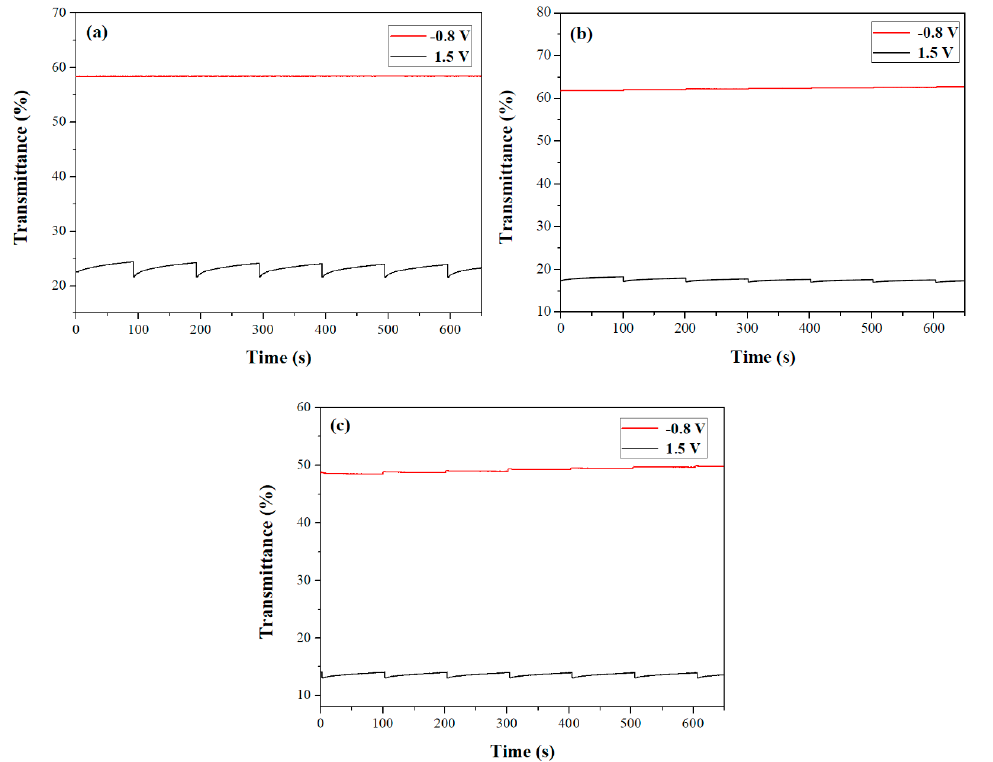
Figure 9. Open circuit stability of ( a ) PdCz/PProdot-Me 2 ; ( b ) P(dCz2- co -dTC2)/PProdot-Me 2 and ( c ) PdTC/PProdot-Me 2 ECDs.